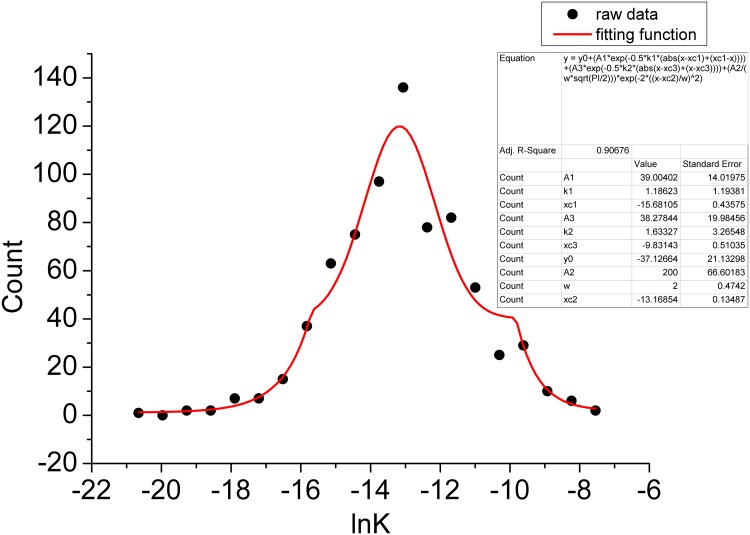
The distribution of the logarithm of equilibrium constant with 720 compounds binding to the Cox2.the vertical axis represents the number of states or probability for the equilibrium constant, gaussian curve: in the center; exponential curve: near the tail. The parameter values for these distributions are presented. The analytical function consisting of a Gaussian and two exponential functions is highlighted with red line.